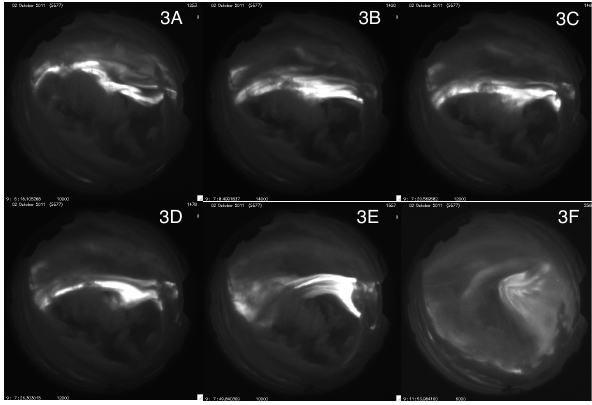
Figure 10. Event 3: all-sky images – taken on 2 October 2011 with a 557.7nm filter – showing the dynamic overall structure of the aurora at the times of the NEIALs in the PFISR data (labeled 3A–3F). North is down and east is to the right.